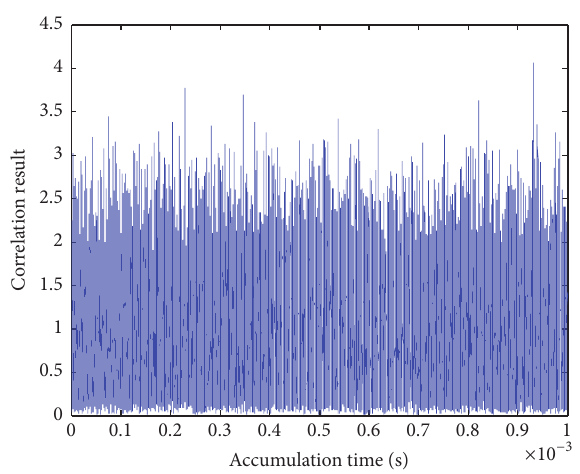
Figure 2: Related search influence